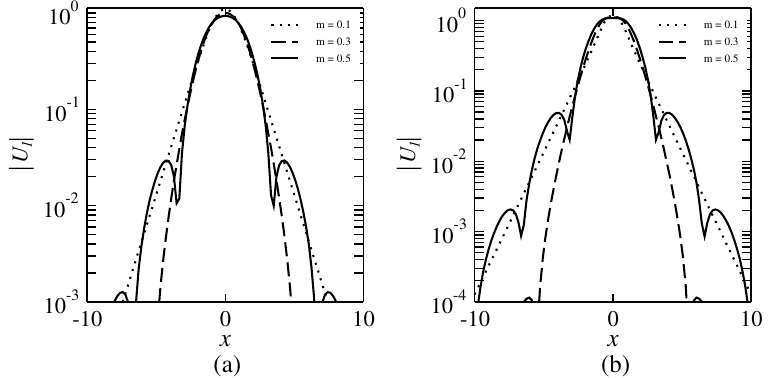
Figure 3. Profiles of the gap solitons with sidebands. ( a ) Type 1 asymmetric soliton at ω = 0.3, η = 0.2, and λ = 0.1; ( b ) Type 2 asymmetric soliton at ω = − 0.5, η = 0.8, and λ = 0.1.